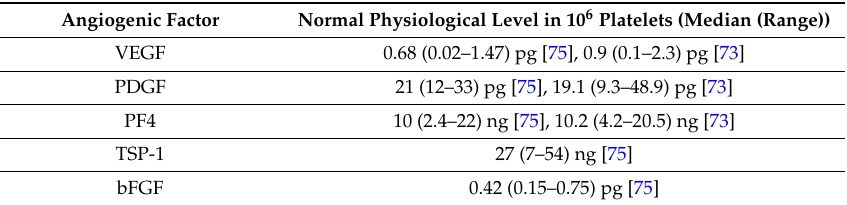
Table 1. Normal physiological levels of angiogenic factors in